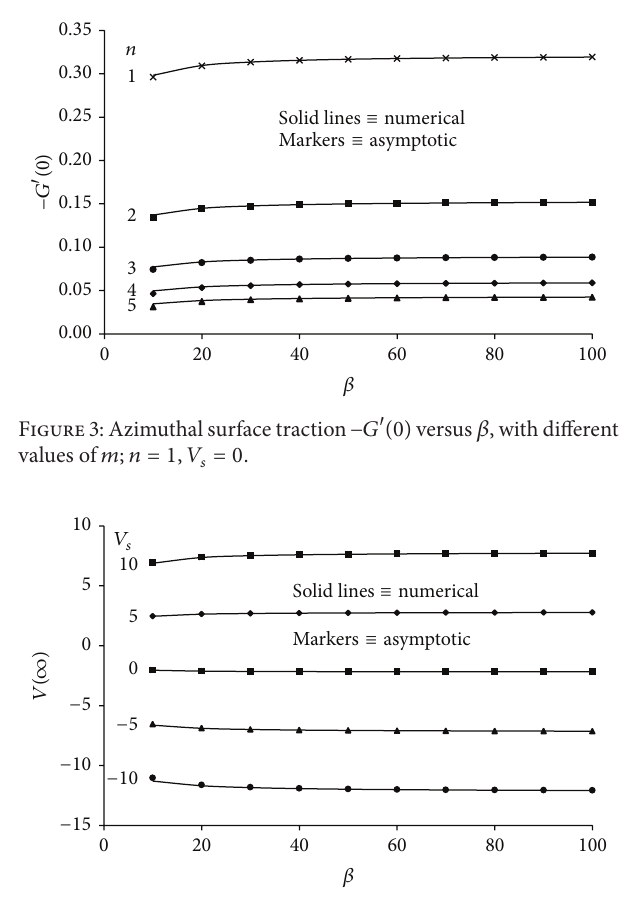
Figure 4: Far-field normal velocity 𝑉(∞) versus 𝛽 , with different values of 𝑉 𝑠 ; 𝑚 = 1 , 𝑛 = 1 .